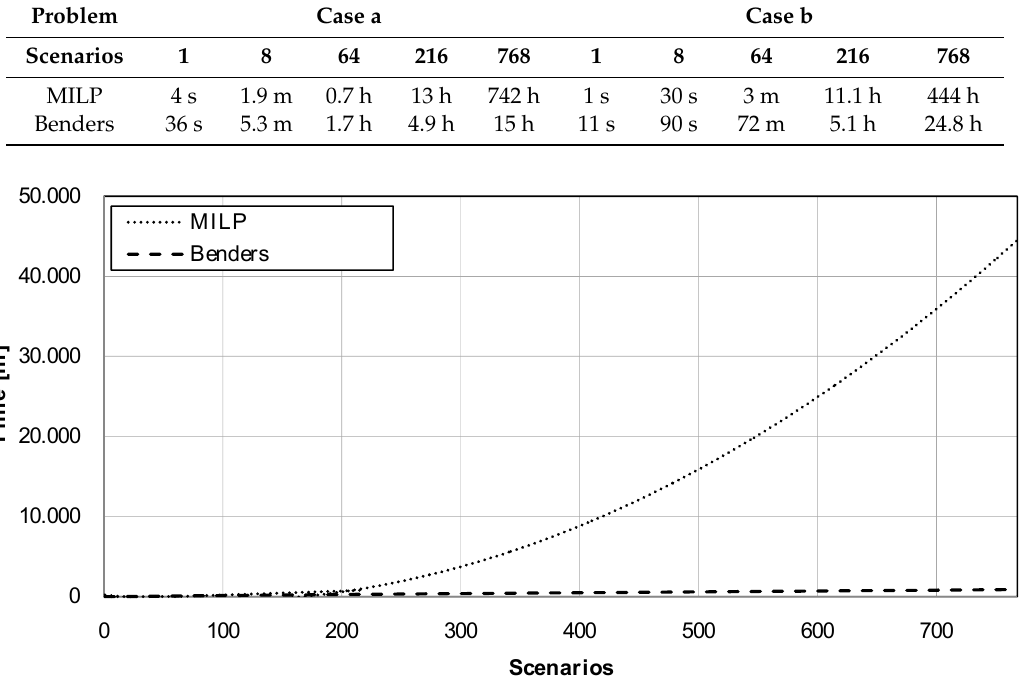
Figure 4. CPU time for Case b. 7. Conclusions This paper has considered the DGP problem in a stochastic environment, where both PV and wind technologies as well as demand are subject to random changes. The use of Benders’ decomposition to solve the two-stage stochastic investment problem has allowed us to further decompose the problem by scenarios and planning periods, making it a fully decomposable one. The model has been tested for a 34-bus example with excellent results.